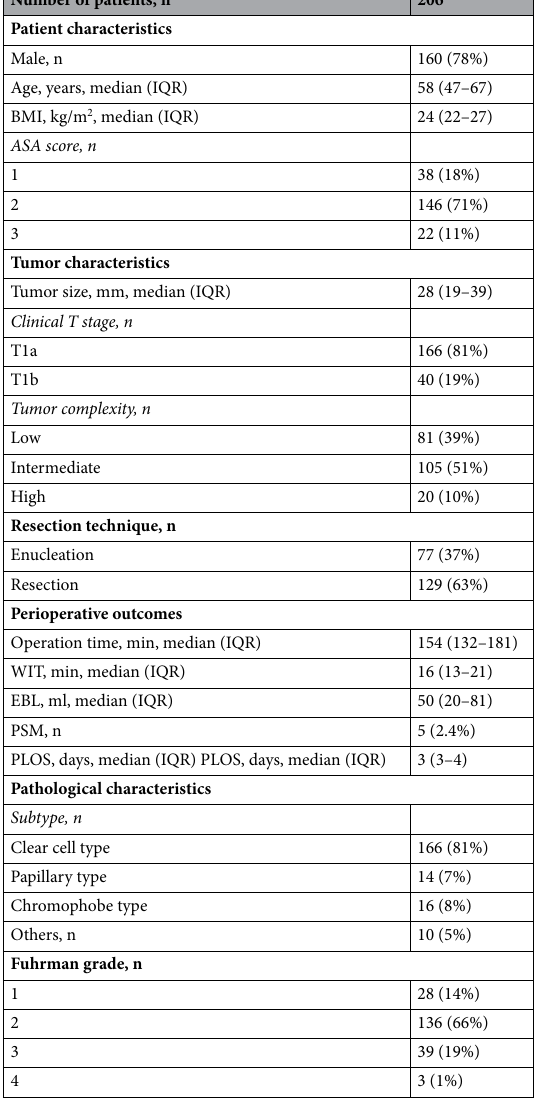
Table 1. Characteristics of patients. BMI body mass index, IQR interquartile range, ASA American Society Anesthesiologists, WIT warm ischemia time, EBL estimated blood loss, PSM positive surgical margin, PLOS postoperative length of hospital stay.